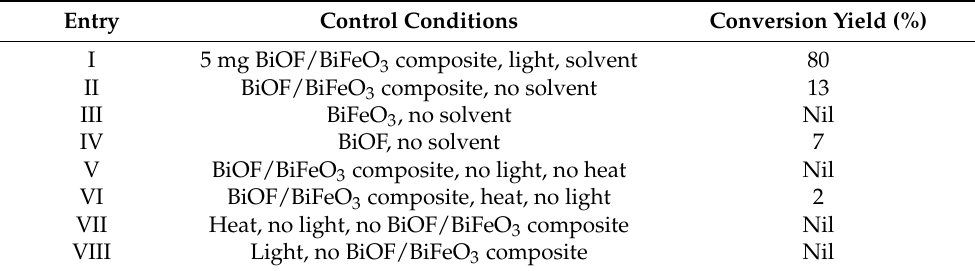
Table 2. Photocatalytic activities under different control conditions.